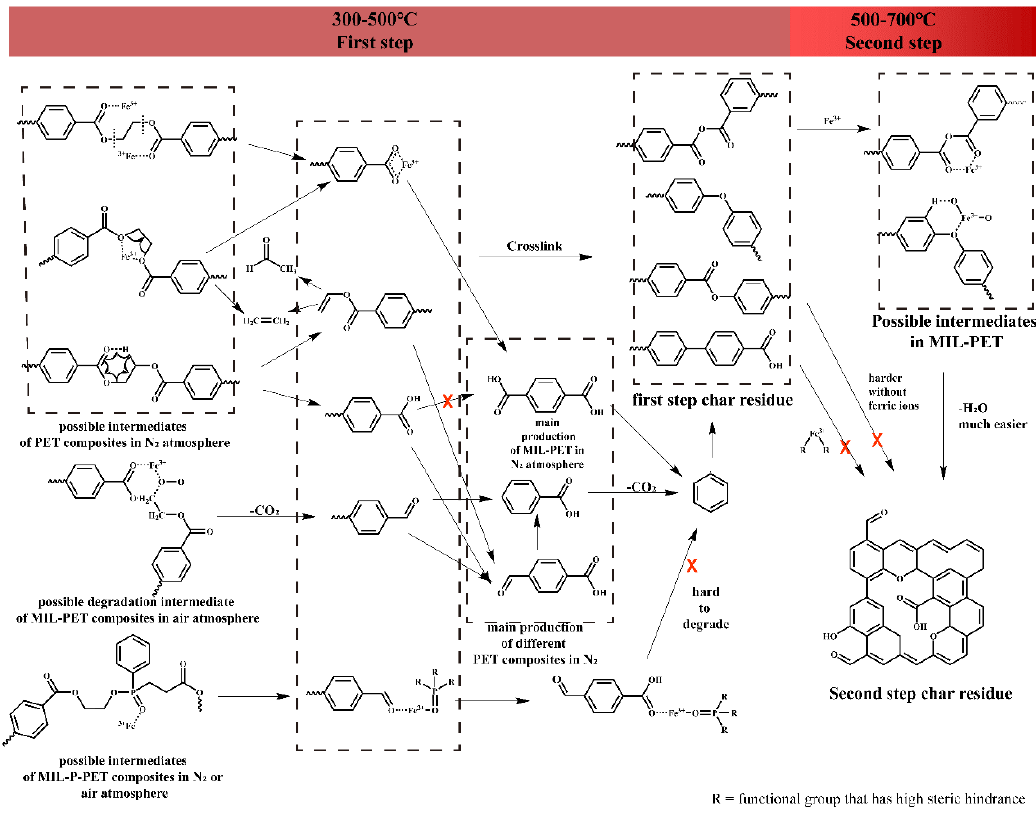
Figure 13. Possible thermal degradation mechanism for MIL-PET.